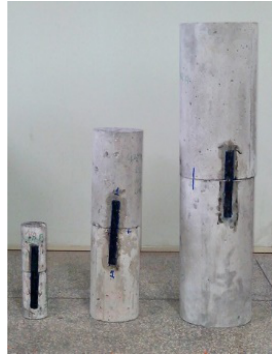
Figure 6. Variation in specimen